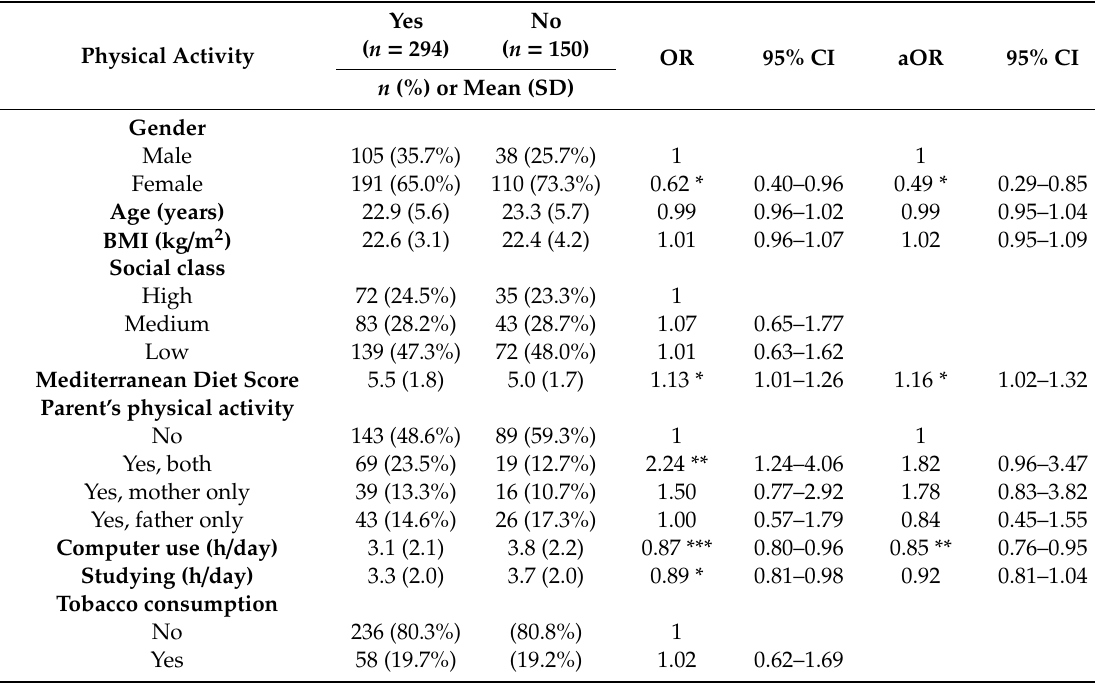
Table 3. Univariate and multivariate analysis of factors associated with physical activity † ( n =